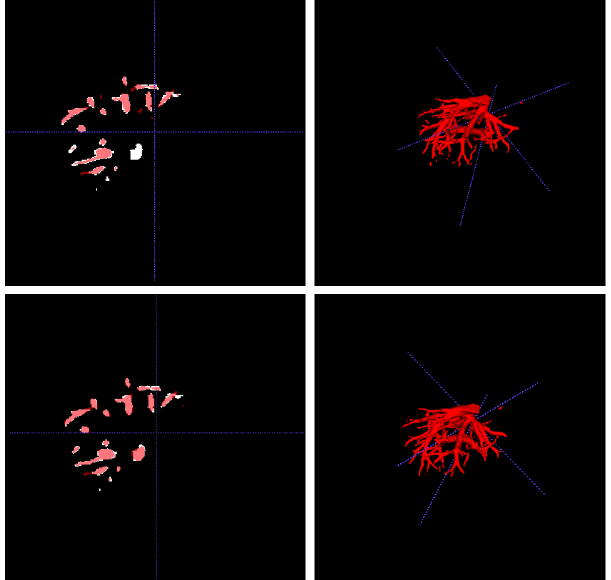
Figure 11. Liver vessel segmentation overlay on ground truth using Frangi enhanced image which has the worst Dice score; 2D slice (top-left) and 3D view (top-right), and SegAdded image which has the best Dice score; 2D slice (bottom-left) and 3D view